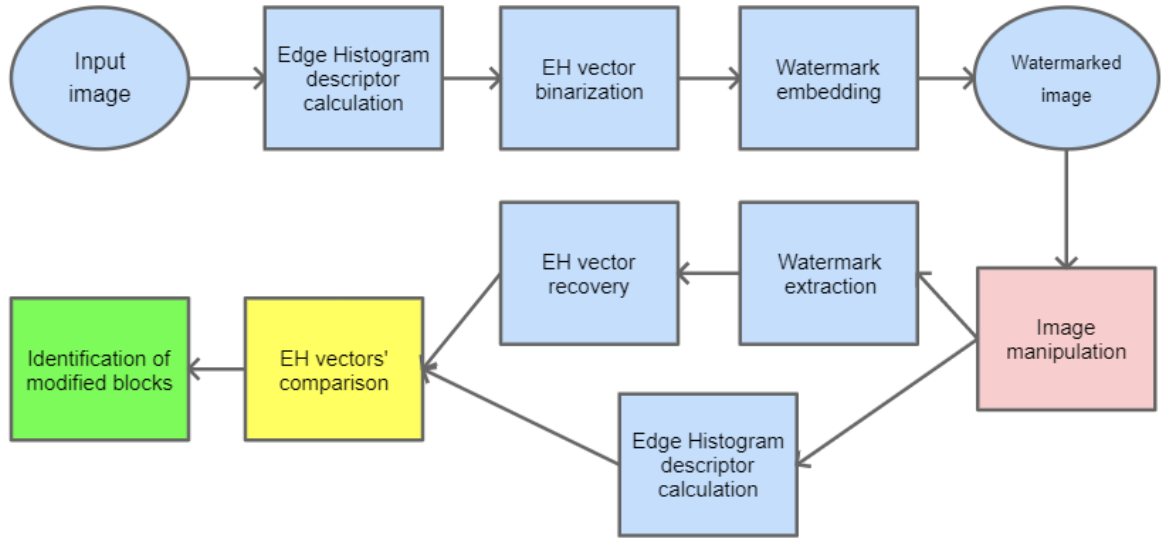
Figure 7. Block diagram for image manipulation detection